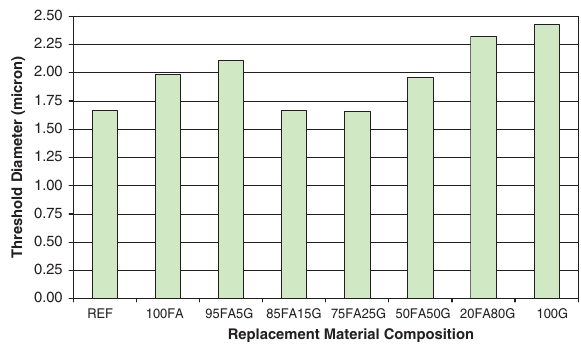
Fig. 8. Pore size distribution of paste P7 Fig. 11. Influence of simulated FGD on the TD of